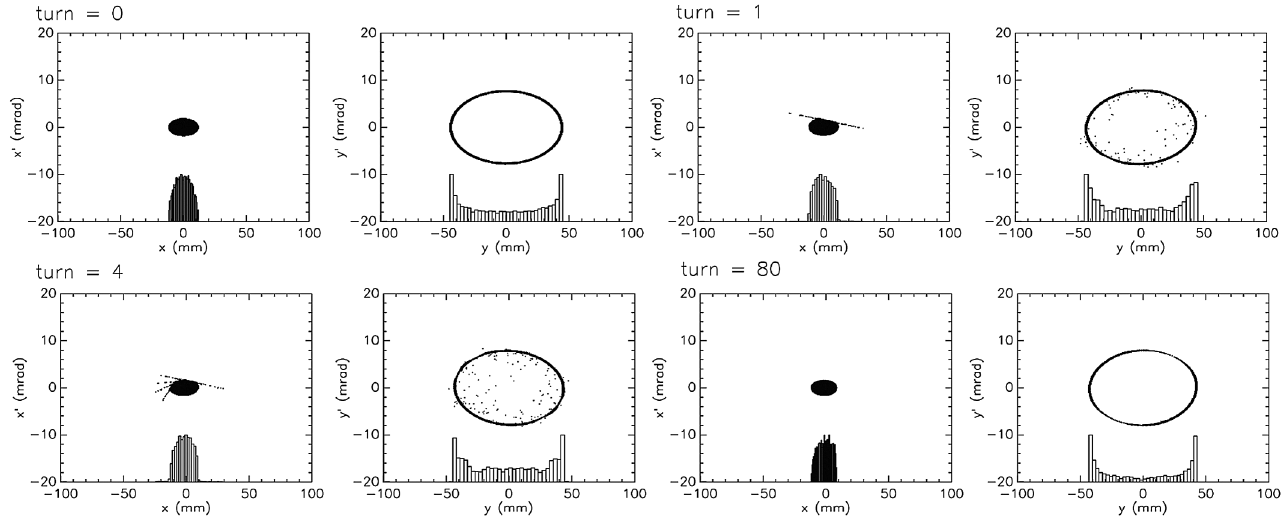
FIG. 9. Beam distributions at the middle point of the dispersion-free long straight section at different turns during the core collimation ( (cid:1) ¼ (cid:1) 1 : 85% , anticorrelated beam, 80